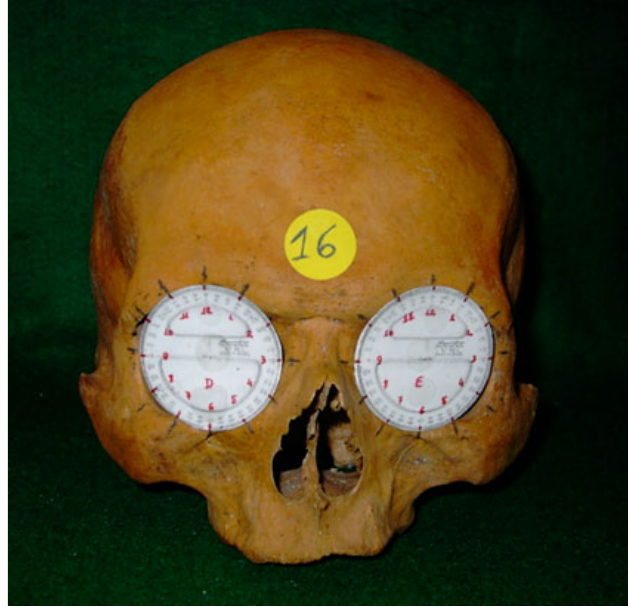
Fig. 1 - Adapted locator in the orbits. Points of reference coinciding with the hours of a clock.